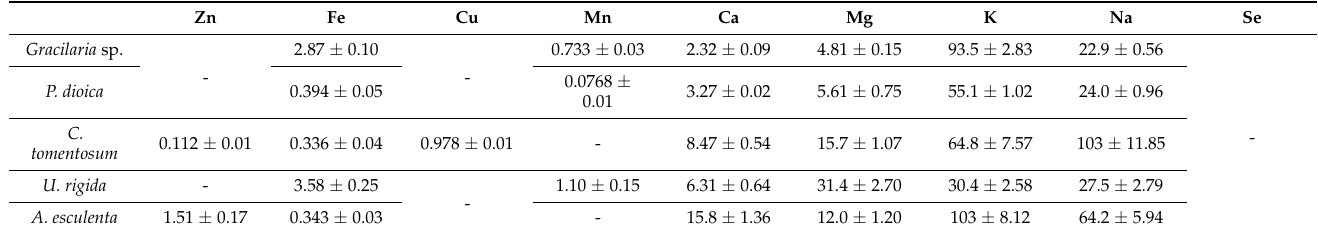
Table 2. Mineral composition of the different seaweeds (g kg − 1 dry